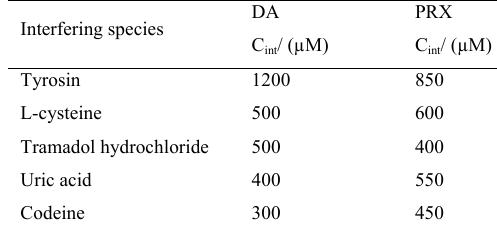
Table 1. Maximum tolerable concentration of interfering